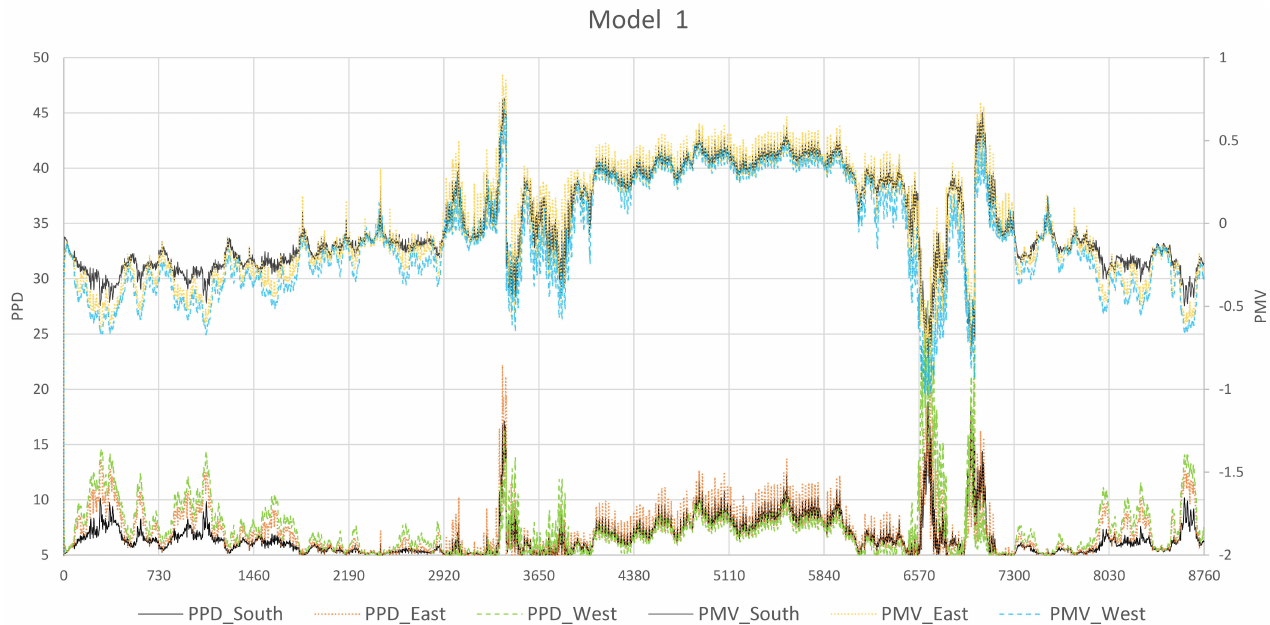
Figure 4. PPD and PMV values for Model 1 in different areas (south, east, and west).